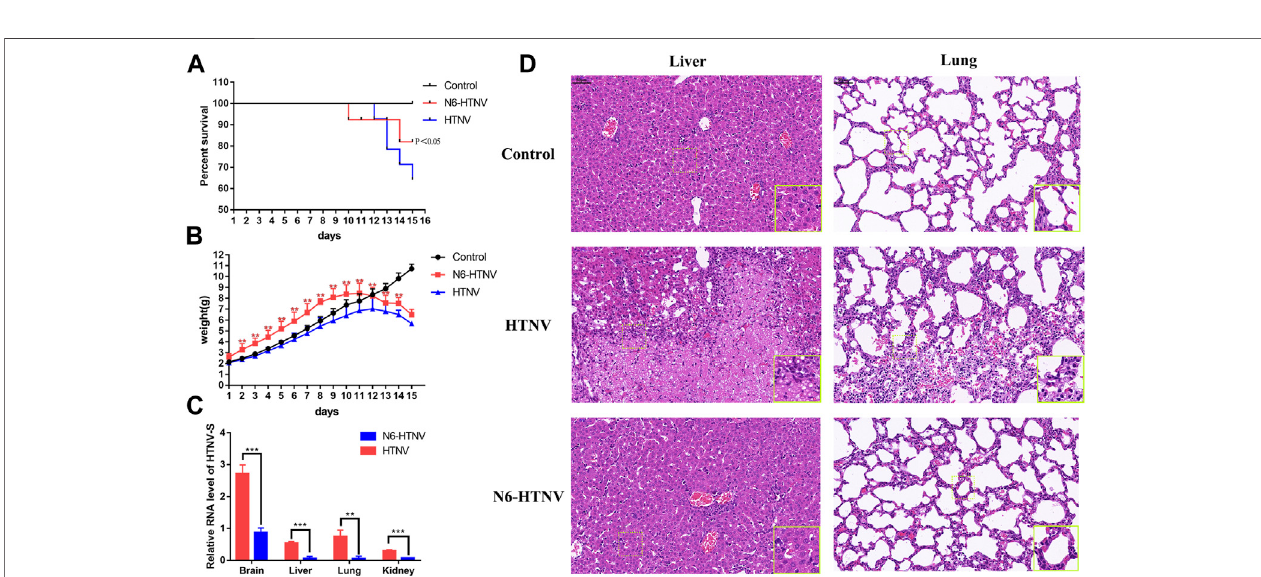
FIGURE5| Invivo therapeuticef fi cacyofN6againstHTNVinfection (A) Survivalofmicefromthenormalcontrolgroup(control),HTNVinfectiongroup(HTNV),and N6-treatedHTNVinfectionmice(N6-HTNV).Resultsofthestatisticalanalysesaredepictedasfollows:Log-ranktest, p -value < 0.05 (B) Thebodyweightofmicefromthe control,HTNV,and N6-HTNVgroupswasmeasured.Resultsofthestatisticalanalysesaredepictedasfollows:two-way ANOVA,** p < 0.01,vsHTNV group,n (cid:2) 15 (C) The relative expression of HTNV-S RNA from the brain, liver, lung, and kidney tissues of N6-HTNV mice and HTNV mice. Results of the statistical analyses are depicted as follows: Student ’ s t test or one-way ANOVA; ** p < 0.01, *** p < 0.001 vs HTNV, n (cid:2) 3 (D) Morphologies of the livers and lungs were examined with H&E staining in mice from the control, HTNV, and N6-HTNV groups. Scale bars represent 50 μ m.